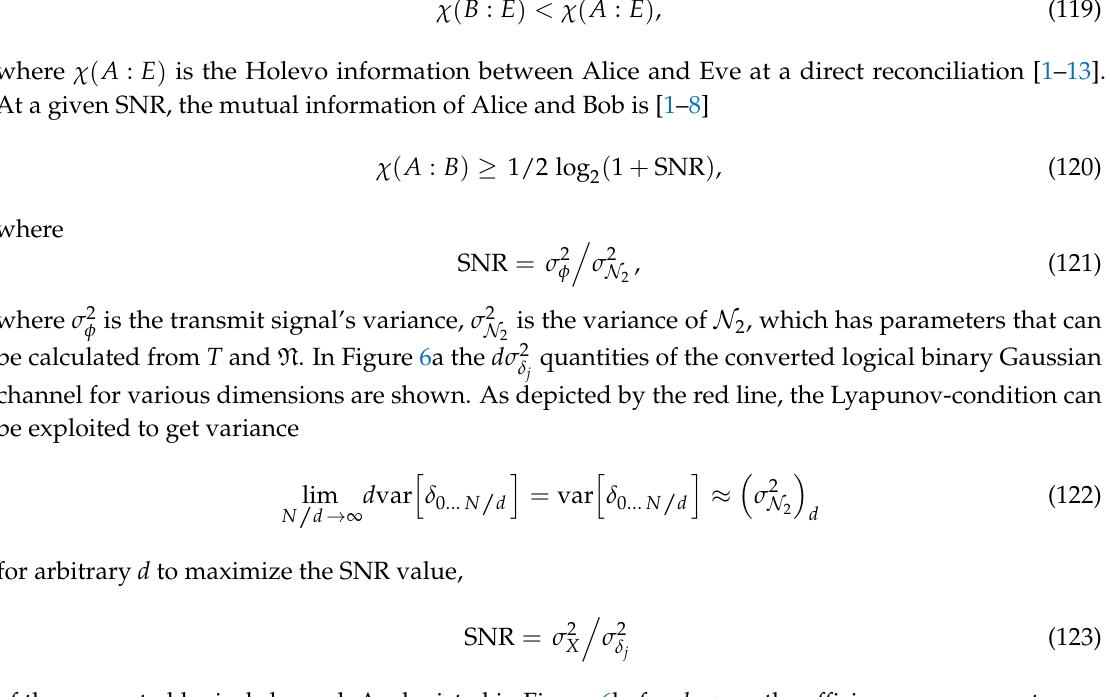
Figure 7. The SNRs of the logical channel at variance 2